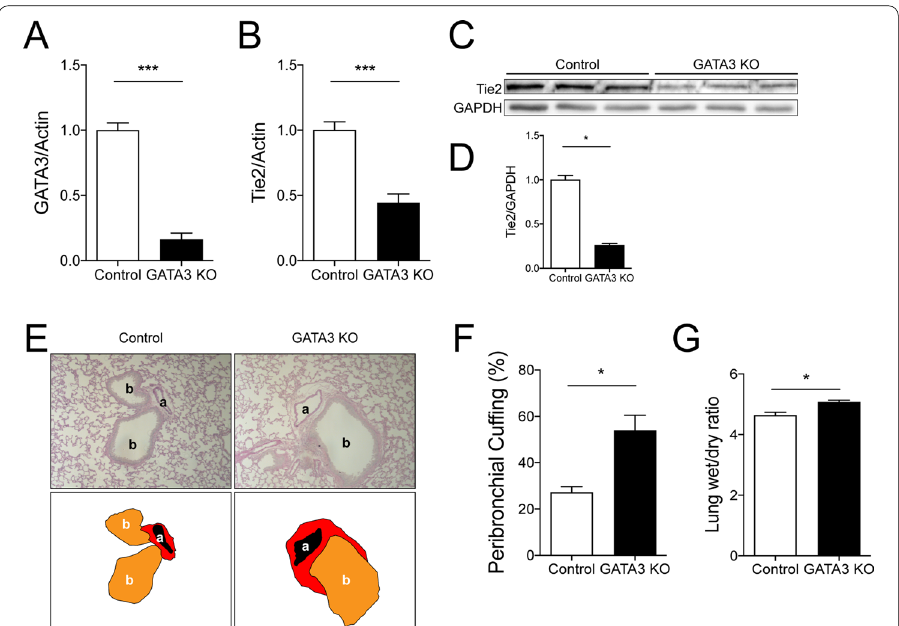
Fig. 4. GATA3 regulates Tie2 expression and vascular permeability in vivo. Graph showing ( A ) GATA3 mRNA and ( B ) Tie2 mRNA expression in ECs isolated from the lungs of endothelial GATA3 knock-out mice and controls (*** p < 0.001, n 7 per group). C Representative immunoblot of whole-lung lysates for Tie2 = expression in endothelial GATA3 knock-out mice and control mice ( D ) densitometric quantification of blots (* p < 0.05, n 5 per group). E Periodic acid-Schiff (PAS) staining of paraffin-embedded lung tissue = in clonidine-induced hypotension mice and saline-treated controls. All images show bronchus (b), their corresponding arteriola (a) and the peribronchial cuffing (a surrogate of lung edema) The schematic illustration below highlights this peribronchial cuff area (in red). F) Semi-quantification of peribronchial cuffing was performed by surveying whole lung sections. (* p < 0.05, n 4 per group). G Lung wet-to-dry = weight ratio of saline-treated controls and clonidine-induced hypotension group (* p < 0.05, n 8 per =